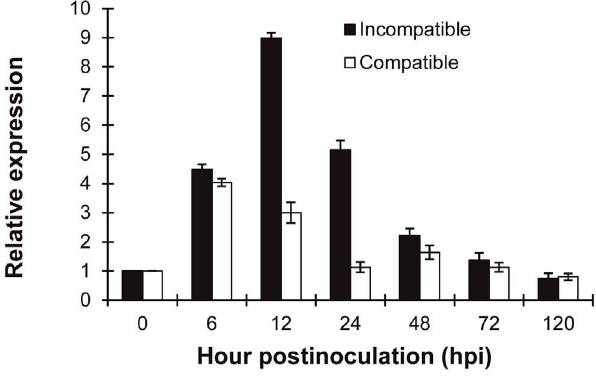
Figure 3. Assays for the transcript levels of TaRab7 during different infection stages. Expression levels of TaRab7 in wheat leaves inoculated with CYR23 (incompatible reaction) and CYR31 (compatible reaction) sampled at 0, 6, 12, 24, 48, 72, and 120 hpi. Relative expression was calculated by the comparative threshold ( DD CT) method. Mean and standard deviation were calculated with data from three independent biological replicates.